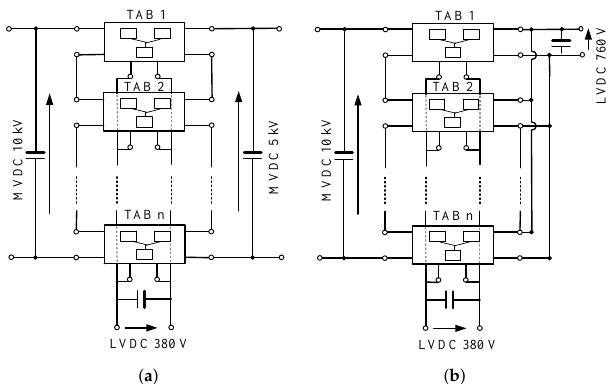
Figure 13. Multiple TAB converter for high voltage high power application: ( a ) two ports in series, one port in parallel; ( b ) one port in series, two ports in parallel.